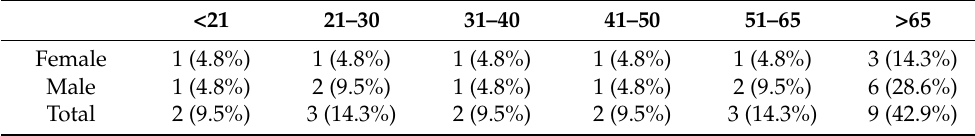
Table 1. Gender and age distribution of the collected samples.